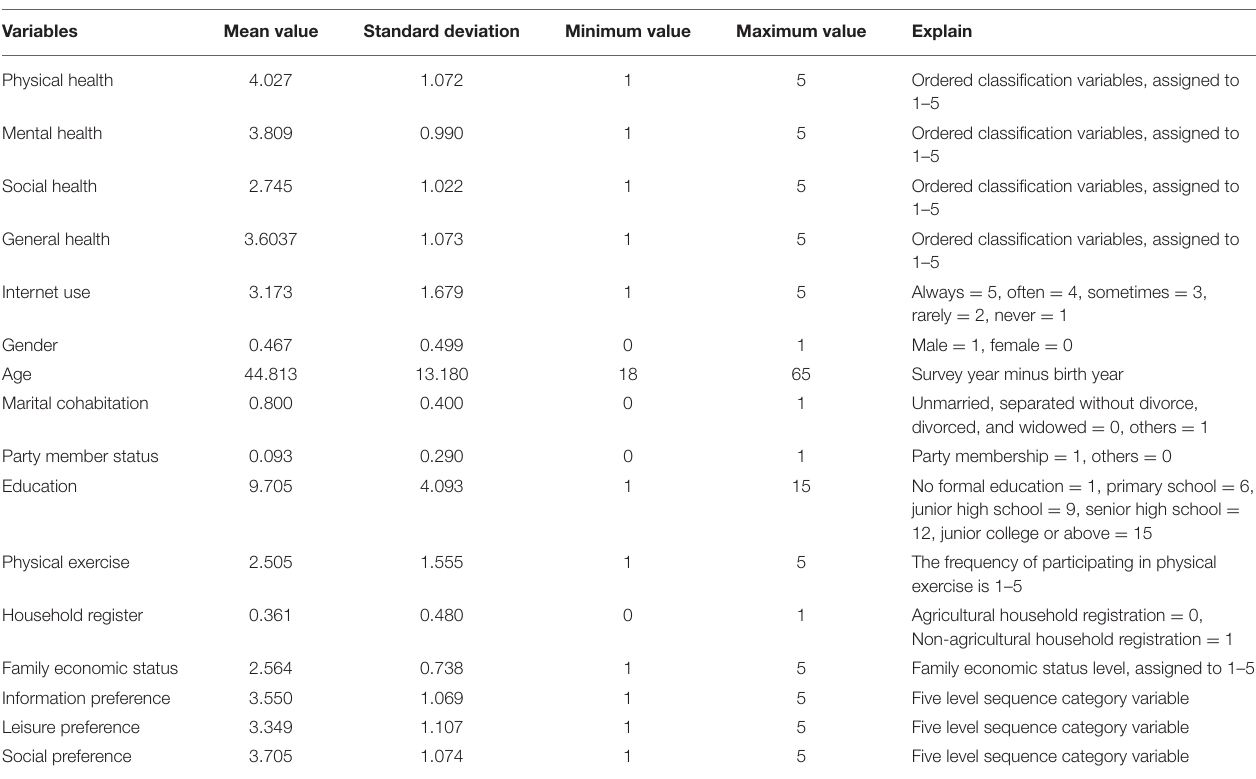
TABLE 1 | Descriptive statistics of